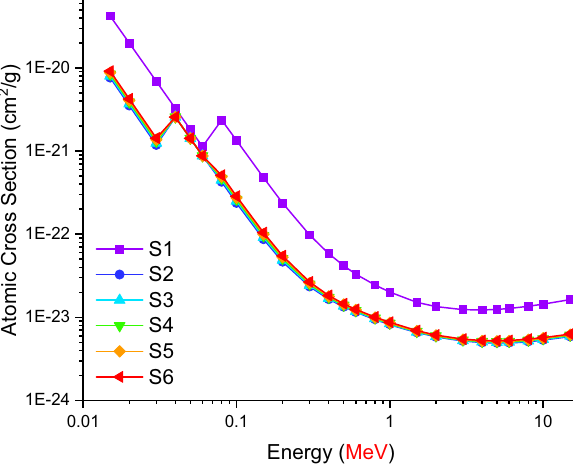
Figure 7: Variations of atomic cross - section with photon energy ( MeV ) for all S1 – S6 glasses.